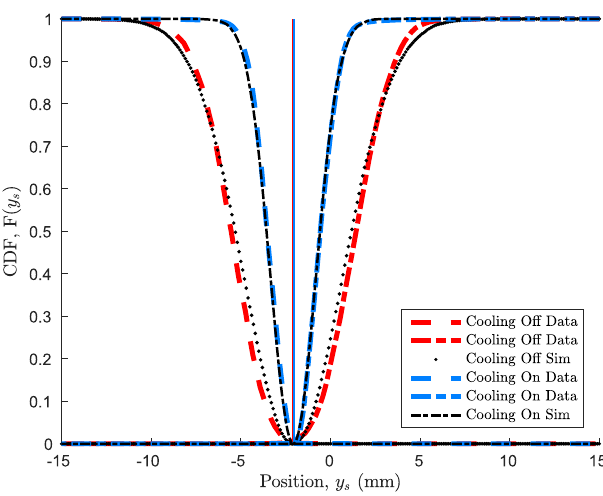
FIG. 5. Horizontal measured CDFs for scraper measurements at 650 keV. Calculated dispersion-dependent closed orbit values are displayed.